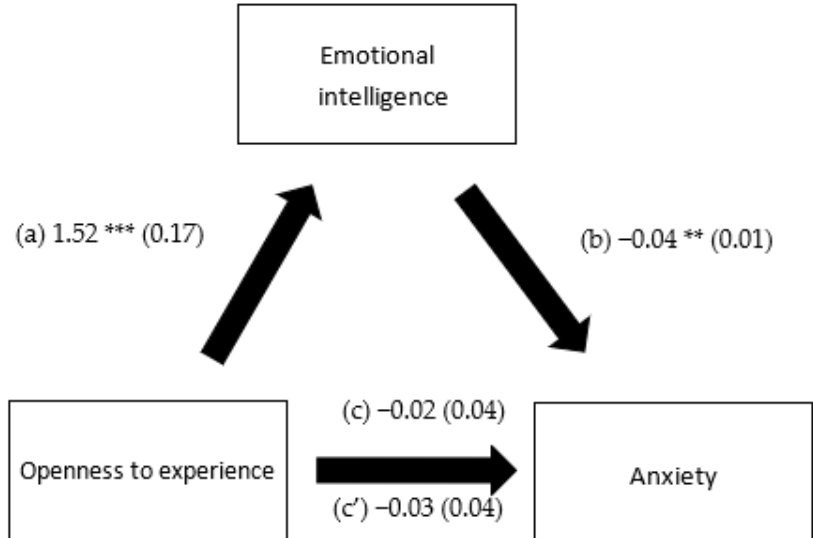
Figure 4. (a) Relation between openness to experience and emotional intelligence (R 2 = 0.294); (b) relation between emotional intelligence and anxiety (R 2 = 0.284); (c) total effect of the relation between openness to experience and anxiety (R 2 = 0.270); and (c’) direct effect of the relation between openness to experience and anxiety. Numbers are displayed as regression coefficients (standard error). ** p < 0.01; *** p < 0 .001.